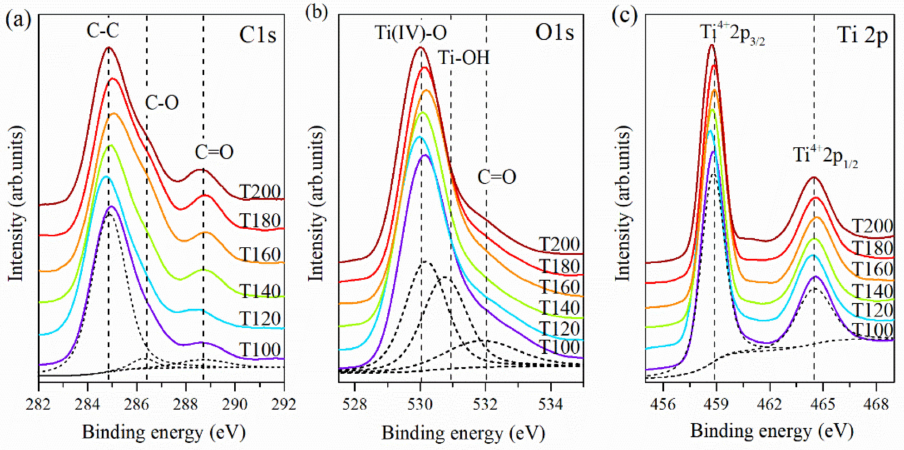
Figure 3. XPS spectra for all TiO 2 NP photocatalyst samples. Deconvoluted peaks are presented as dash black lines: ( a ) C 1s, ( b ) O 1s, and ( c ) Ti 2p.